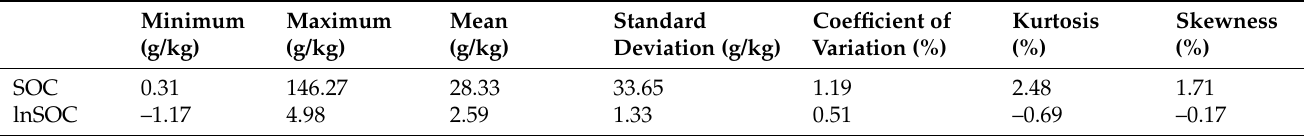
Table 2. Descriptive statistics of the original and logarithmic SOC observations.